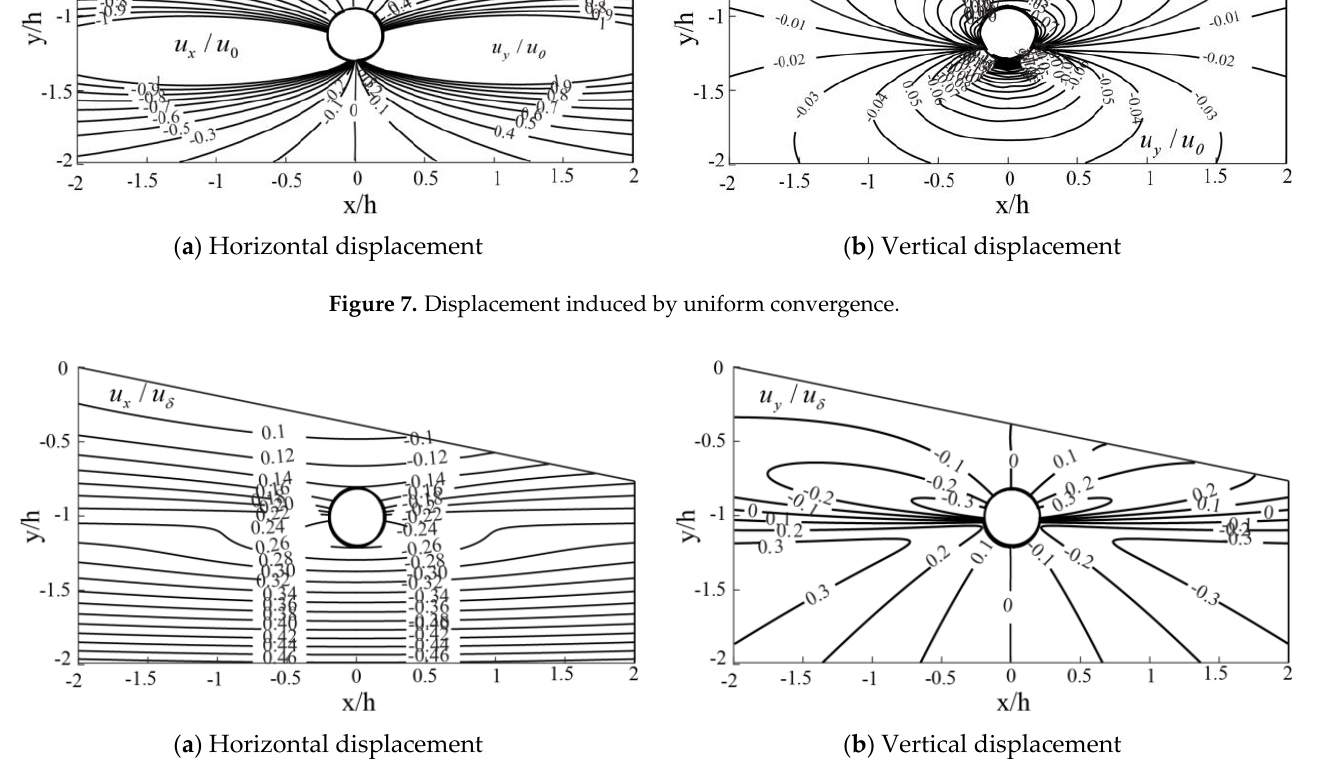
Figure 8. Displacement induced by ovalization.